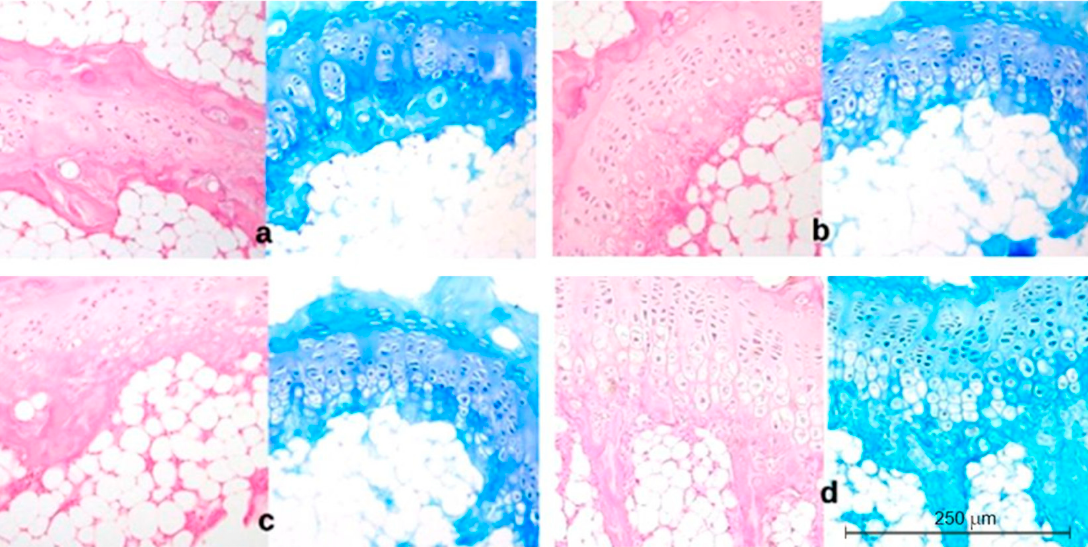
Figure 4. Group II. Histopathological image of cartilage from the concave side ( a ): irregular arrange- ment of the columns of the proliferative layer, thin growth cartilage, atrophic hypertrophic zone; central side ( b ): regular arrangement of the columns of the proliferative and hypertrophic layers; convex side ( c ): less regular arrangement of the columns of the proliferative and hypertrophic layers than in the control group, active hypertrophic layer; control group ( d ): normal and regular arrange- ment of the columns of the proliferative and hypertrophic layer, wide growth cartilage, fully active hypertrophic layer. Seventy-three-day-old animals (completion of scoliosis induction); H&E and Methyl Blue staining 200×.